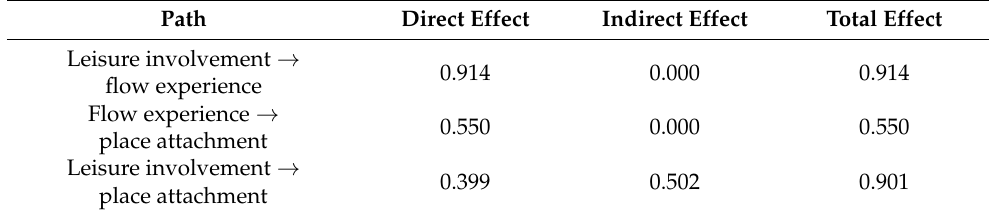
Table 6. Effects between the latent variables of the hypothetical model.